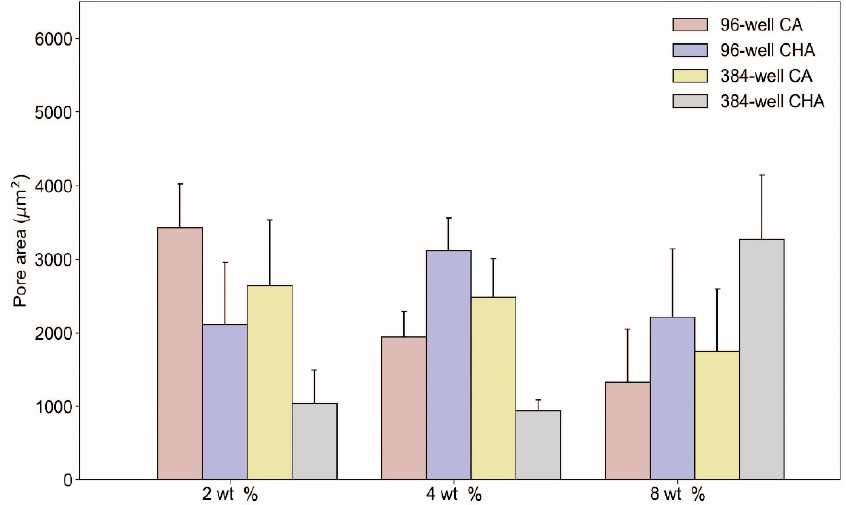
Figure 7. Pore area of CA and CHA scaffolds. The mean pore area of 2, 4, and 8 wt % CA and CHA scaffolds dispensed in both 96- and 384-well plates. Data are displayed as the average with the error bars indicating the standard deviation ( n ≥ 60).